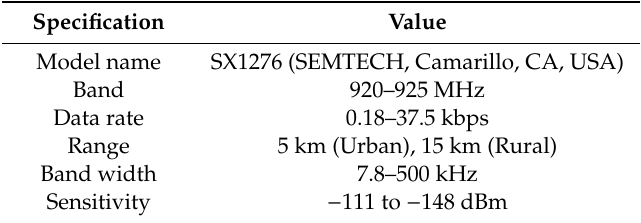
Figure 4. Hardware components of the platform. Table 3. Technical specification of the low-power wide-area network (LoRa)